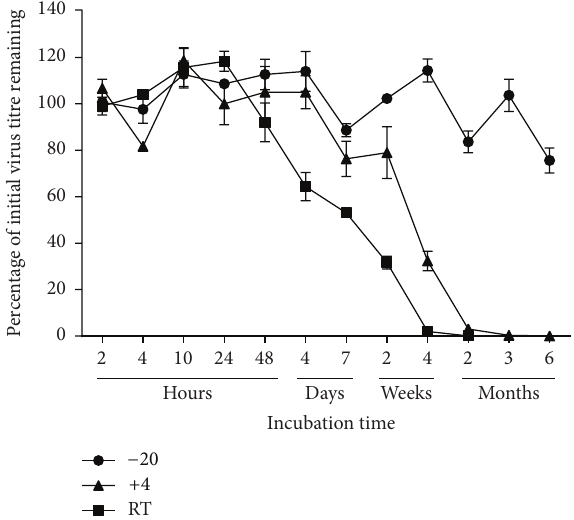
Figure 3: The influence of different storage temperatures on pseudotype virus titre. The stability of H5N1 lacZ pseudotypes was evaluated by storing aliquots of virus at different temperatures for up to 6 months. Pseudotype titres for the time course are given relative to the titre of virus stocks maintained at − 80 ∘ C which is considered the optimal storage temperature for retroviral pseudotypes. One biological replicate pseudotype virus was used to generate three technical replicates. Error bars represent standard